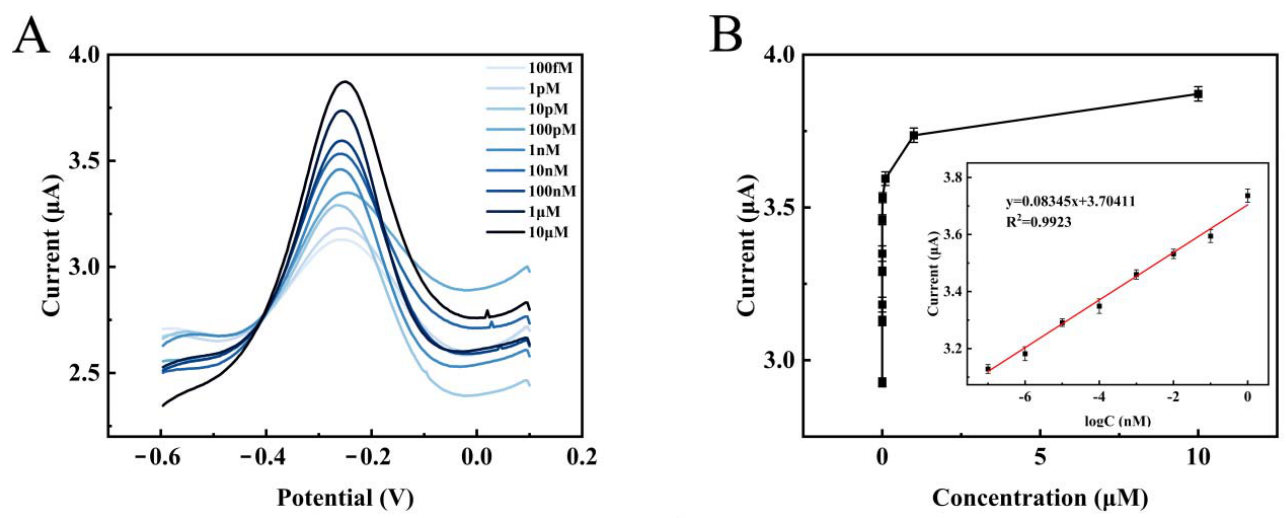
Figure 7. ( A ) DPV curves for different concentration of TD (1.0 × 10 − 13 , 1.0 × 10 − 12 , 1.0 × 10 − 11 , 1.0 × 10 − 10 , 1.0 × 10 − 9 , 1.0 × 10 − 8 , 1.0 × 10 − 7 , 1.0 × 10 − 6 , and 1.0 × 10 − 5 mol/L). ( B ) Relationship between TD concentrations and DPV intensities. Insert: calibration curve between the logarithm of TD concentrations and Δ I. Table 2. Comparison between the proposed DPV sensor and other sensors for HPV ‐ 16 assay. Dynamic Line Arrange (mol/L)